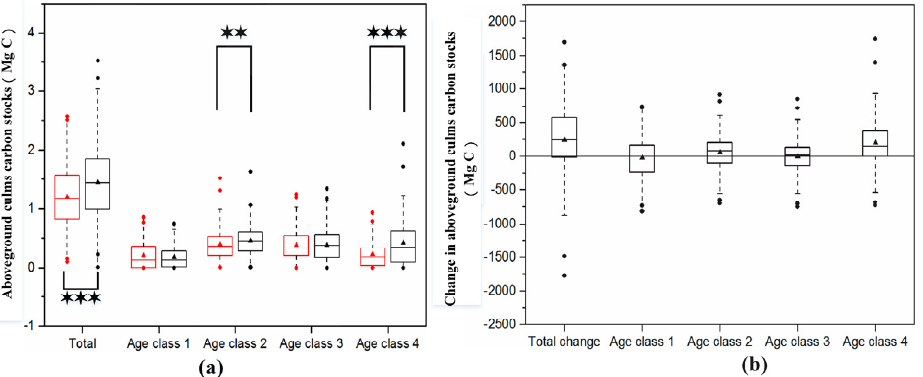
Figure 3. Aboveground culms carbon stocks ( a ) and change in carbon stocks ( b ) in all sample plots. Red color represents the carbon stocks in 2009, and black color represents the carbon stocks in 2014 in ( a ). The symbols ** and *** denote significant differences between carbon stocks in 2009 and 2014 at p < 0.01 and p < 0.001, respectively.